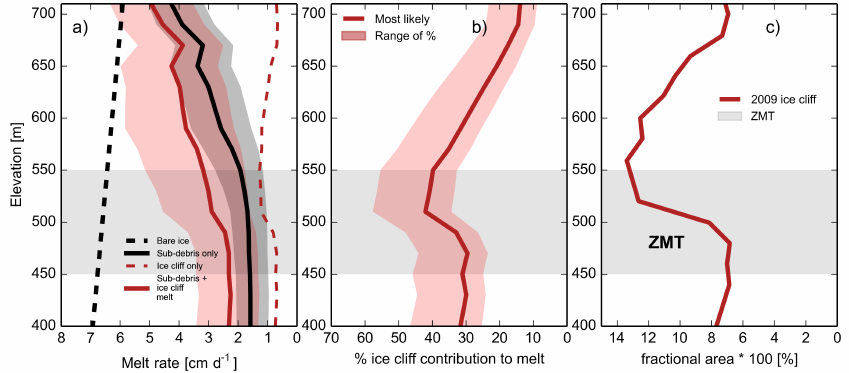
Figure 12. Distributed melt rate estimates with elevation. The zone of maximum thinning (ZMT) is represented by light grey bands for all panels. All panels use 20m elevation bins. Elevations are relative to the 2013 glacier surface. (a) The elevation-band-averaged ( absolute ) melt rate over the study period. The red band contains an extreme range of sub-debris plus ice cliff melt based on compounding parameter choices such that 98.4% of estimates lie within it (see Sect. 2.3.1). A total of 84.1% of estimates for sub-debris melt are within the grey shaded band. Five additional distributed melt rate scenarios are presented in Sect. S3. Bare-ice estimates are based on the near-surface air temperature lapse rate from off-glacier meteorological stations and a degree-day factor for bare-ice melt (Sect. S1.6). The decrease in sub- debris melt rate at 670ma.s.l. is related to the increased area of medial moraine no. 9 within the study area, which is covered with relatively thick debris. (b) The fractional ( relative ) contribution of ice cliffs to the area-averaged melt rate (sub-debris + ice cliff) with elevation. The red band contains the extreme range of melt contributions from ice cliffs. (c) The fractional area × 100 (%) coverage of ice cliffs. Table 3. Comparison of ice cliff backwasting rates and debris thicknesses with other glaciers. Glacier Region Latitude Mean Range of Mean debris Reference [deg.] study area backwasting thickness elevation [m] rates [cmd − 1 ] [cm] Kennicott Alaska 61 600 This study Miage Alps, Italy 46